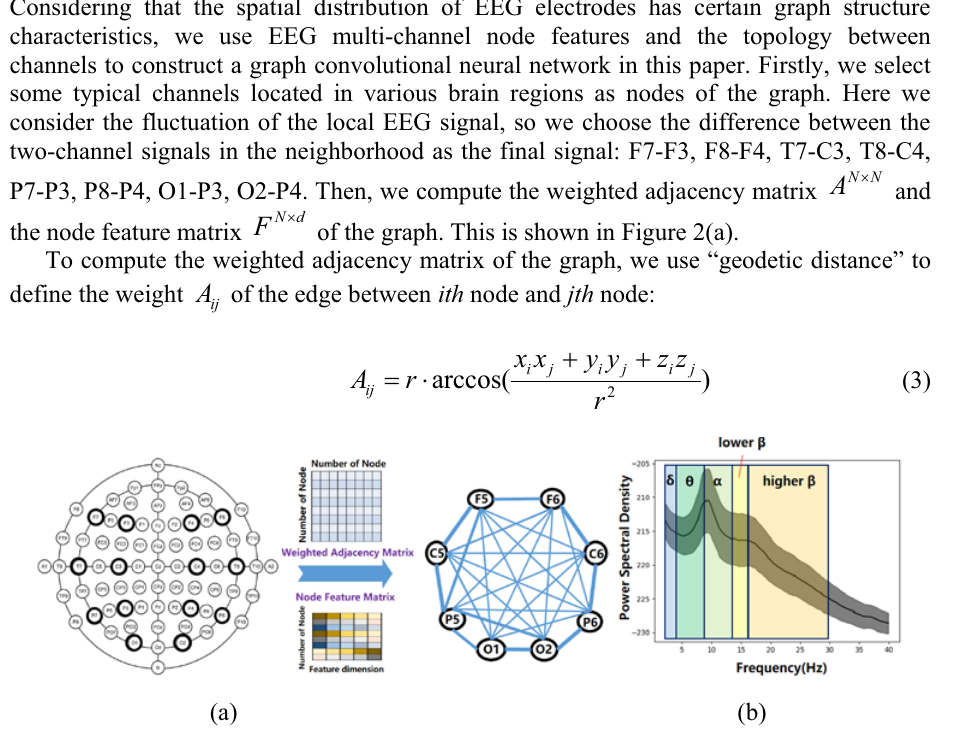
Fig. 2. (a) Schematic diagram of the process of constructing the topological graph of EEG features by multi-channel resting state EEG; (b) Feature extraction based on power spectral